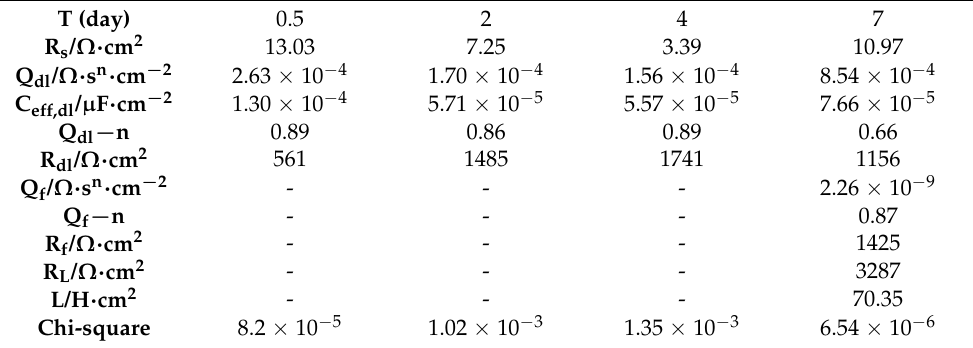
Table 7. Electrochemical impedance parameters fitted from EIS